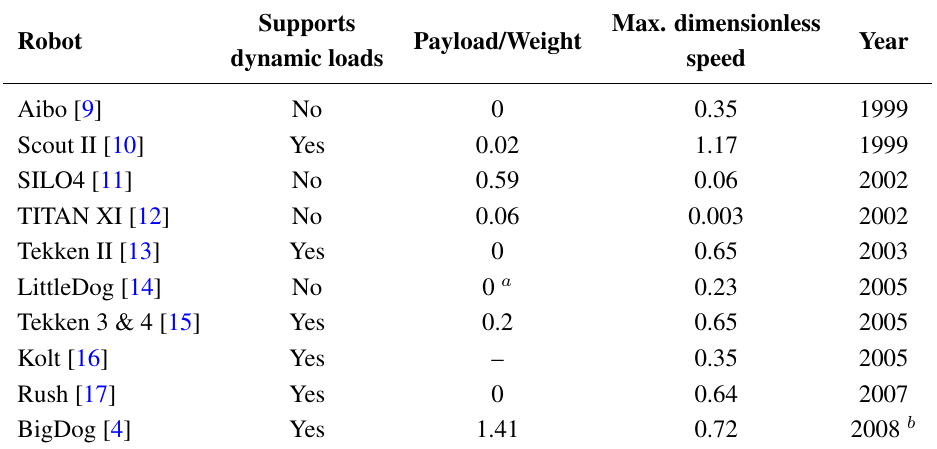
Table 1. Performance of significant quadruped robots developed in the last 12 years.